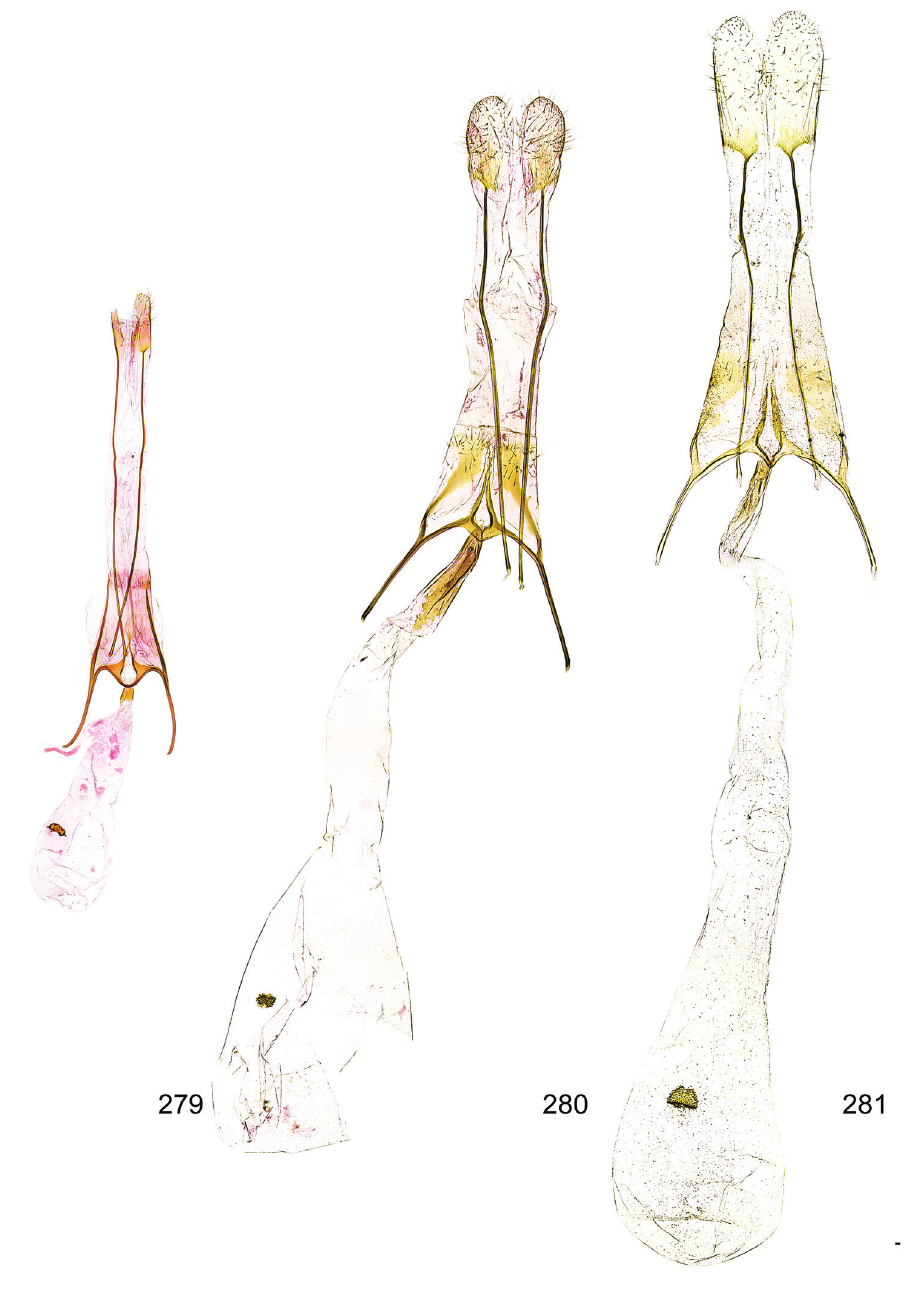
Figures 279–281. Megacraspedus female genitalia. 279 M. sumpichi sp. n. – Paratype, Spain, GU 15/1397 P.H. (RCZT) 280 M. gallicus sp. n. – Paratype, France, GEL 1230 P.H. (TLMF) 281 M. rib- beella (Caradja, 1920) – Spain, gen. slide 16.651